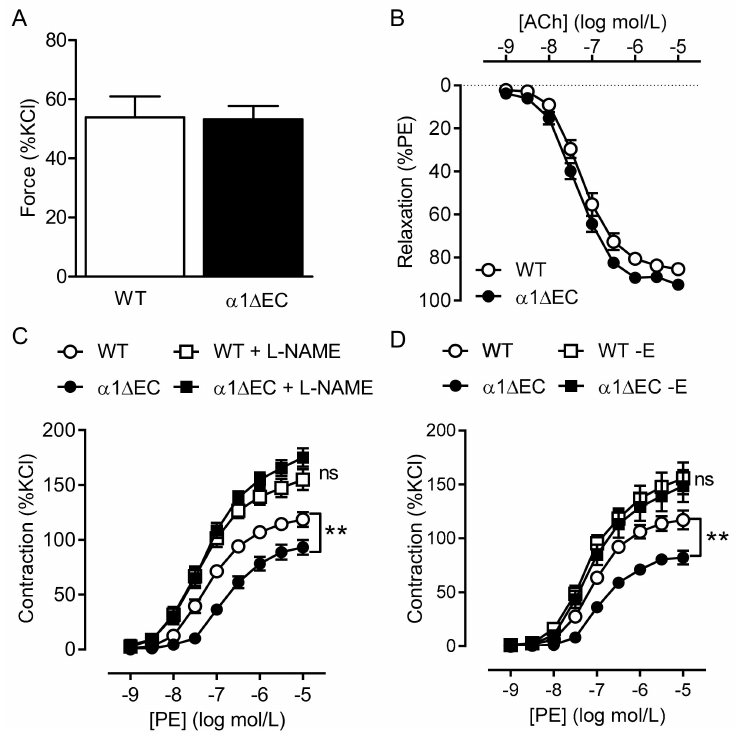
Figure 3. Consequences of endothelial-specific deletion of AMPK α 1 on vascular reactivity. ( A ) Effect of N ω -nitro- L -arginine methyl ester (L-NAME; 300 µ mol/L) on the tone of aortic rings from wild-type (WT) and AMPK α 1 ∆ EC ( α 1 ∆ EC) mice pre-contracted to 30% of the maximal KCl-induced contraction by phenylephrine. ( B ) Concentration-dependent relaxation due to acetylcholine in aortic rings pre-constricted with phenylephrine from wild-type (WT) and AMPK α 1 ∆ EC ( α 1 ∆ EC)